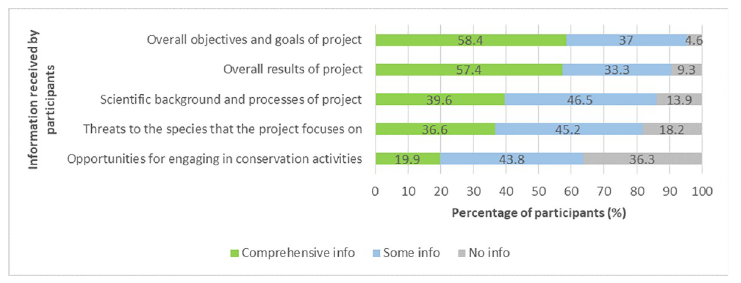
Fig 7. Kinds of information received by the